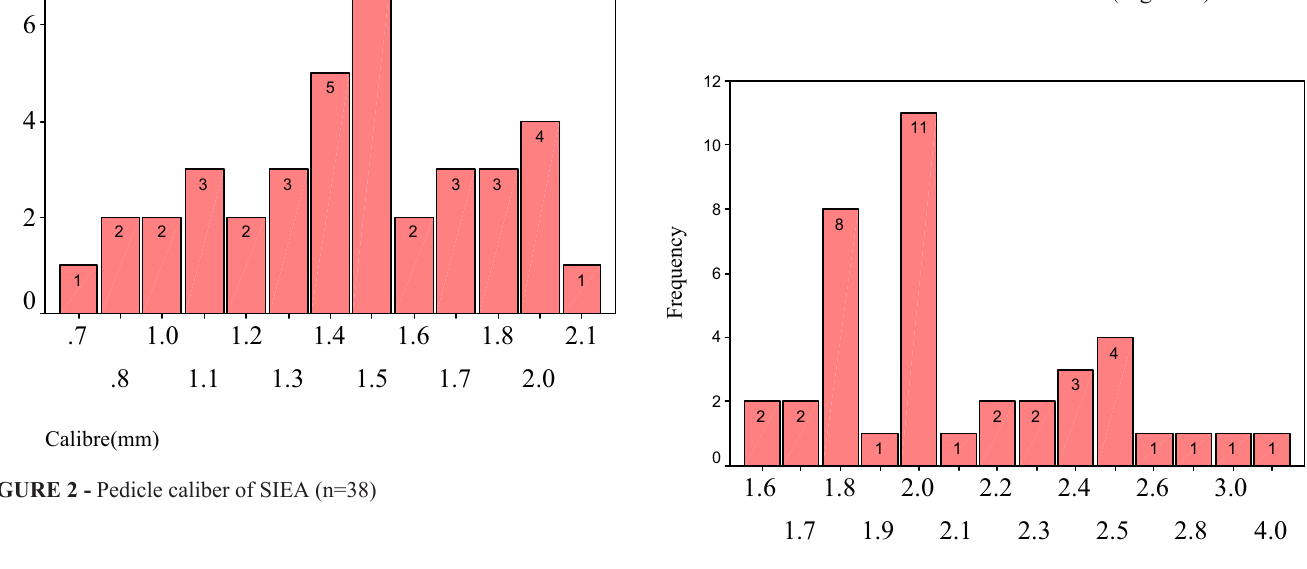
The pedicle caliber of SIEV was measured in all dissec- tions. It ranged from 1.6 to 4 mm with a mean±SD of 2.14±.45 mm. The median caliber of SIEV was 2 mm (Figure 4).